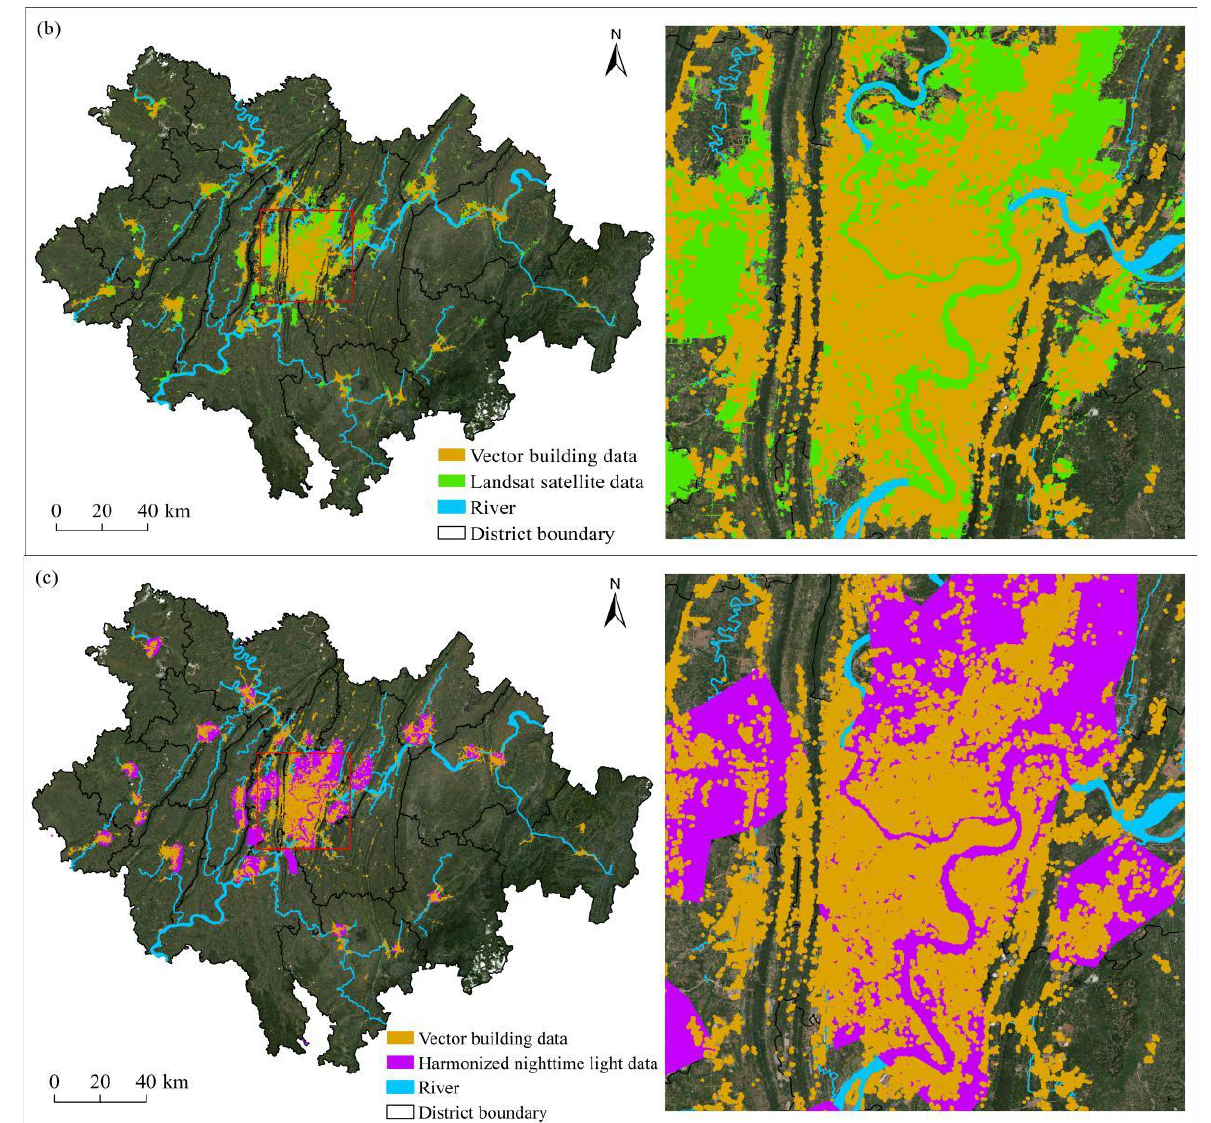
Figure 6. Physical urban area comparison between different types of data and vector building data. Comparison with other identification results using different data and methods, im- pervious surface dataset [38] extracted from Landsat satellites with a spatial resolution of 30 m (http://irsip.whu.edu.cn/resources/dataweb.php, accessed on 1 December 2020) and an urban extent dataset [39] extracted from Harmonized nighttime lights (https: //doi.org/10.6084/m9.figshare.16602224.v1, accessed on 1 December 2020) were